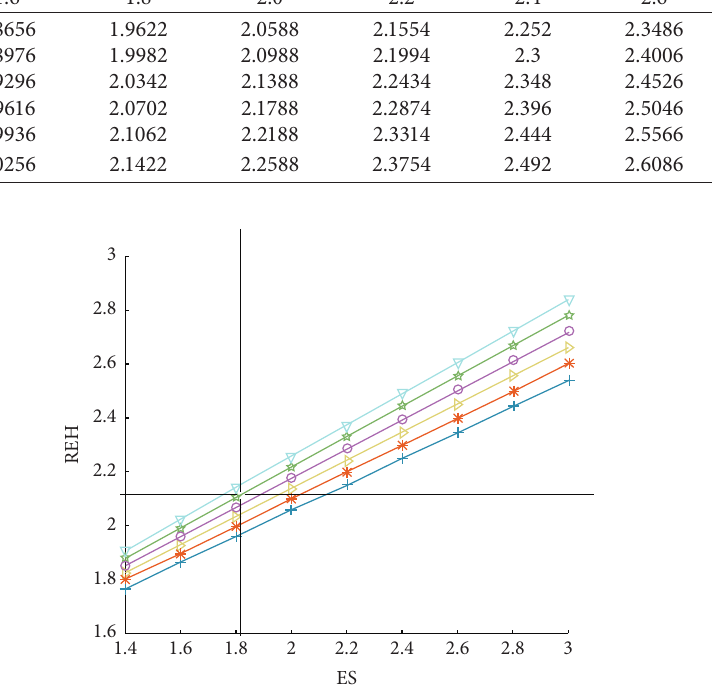
Figure 9: Sensitivity analysis of the health status of higher education in Vietnam.